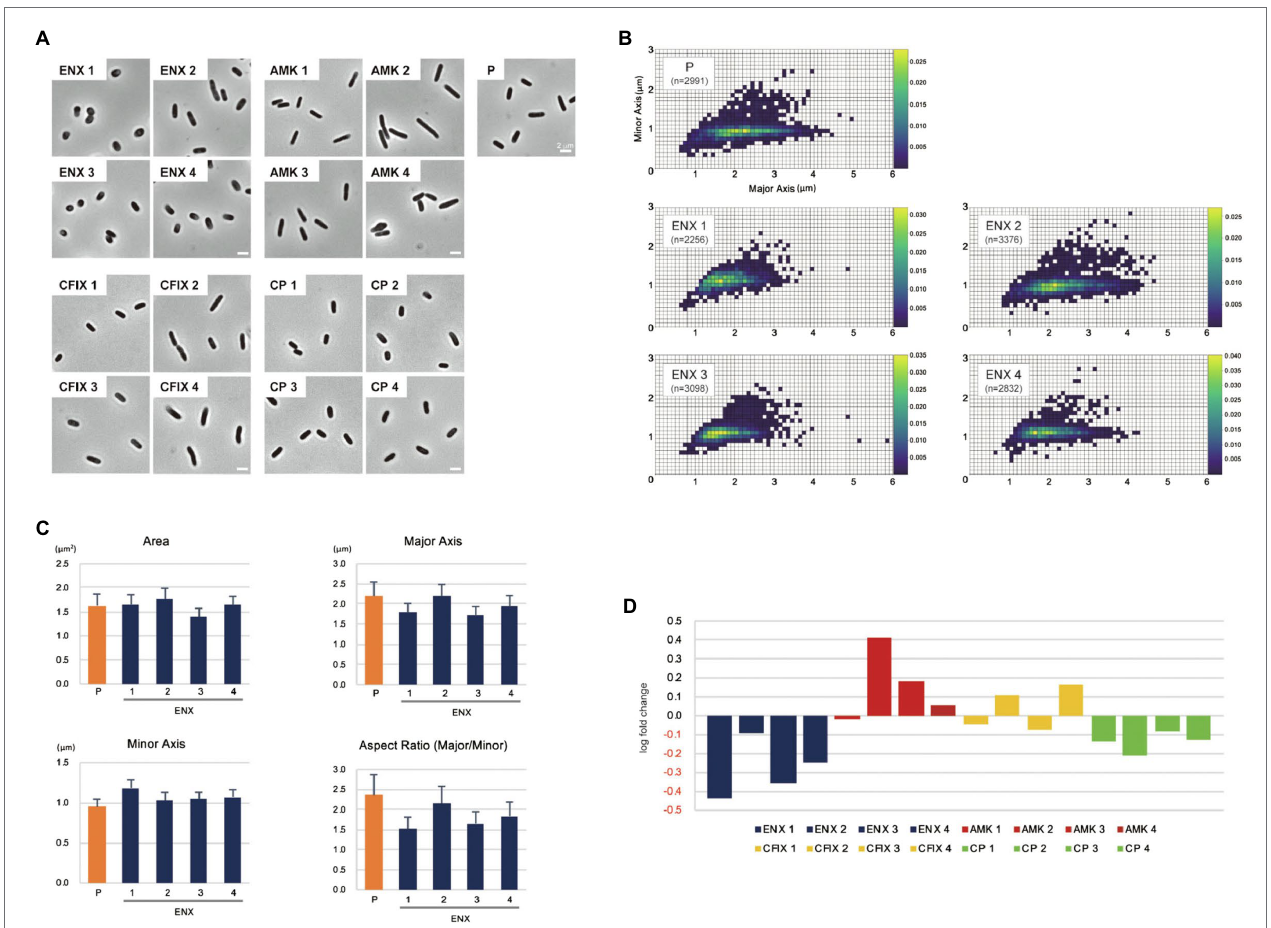
FIGURE 1 | Light microscopy of drug-resistant strains. (A) Representative images of four different drug-resistant strains, enoxacin (ENX), amikacin (AMK), cefixime (CFIX), chloramphenicol (CP), and the parental strain (P) are shown. Scale bars, 2 μ m. (B–D) Results of the morphometric analysis presented as (B) scatter plots of major vs. minor axis lengths of the parental cells and ENX-resistant cells. The color scales indicate the ratio of cell densities. (C) Bar graphs show averages of bacterial cell sizes, major and minor axis lengths, and the aspect ratio. All indicated data were significantly different by p < 0.01, Welch’s t -test. (D) Logarithmic changes in the average aspect ratio of the indicated drug-resistant strains against the parental strain are